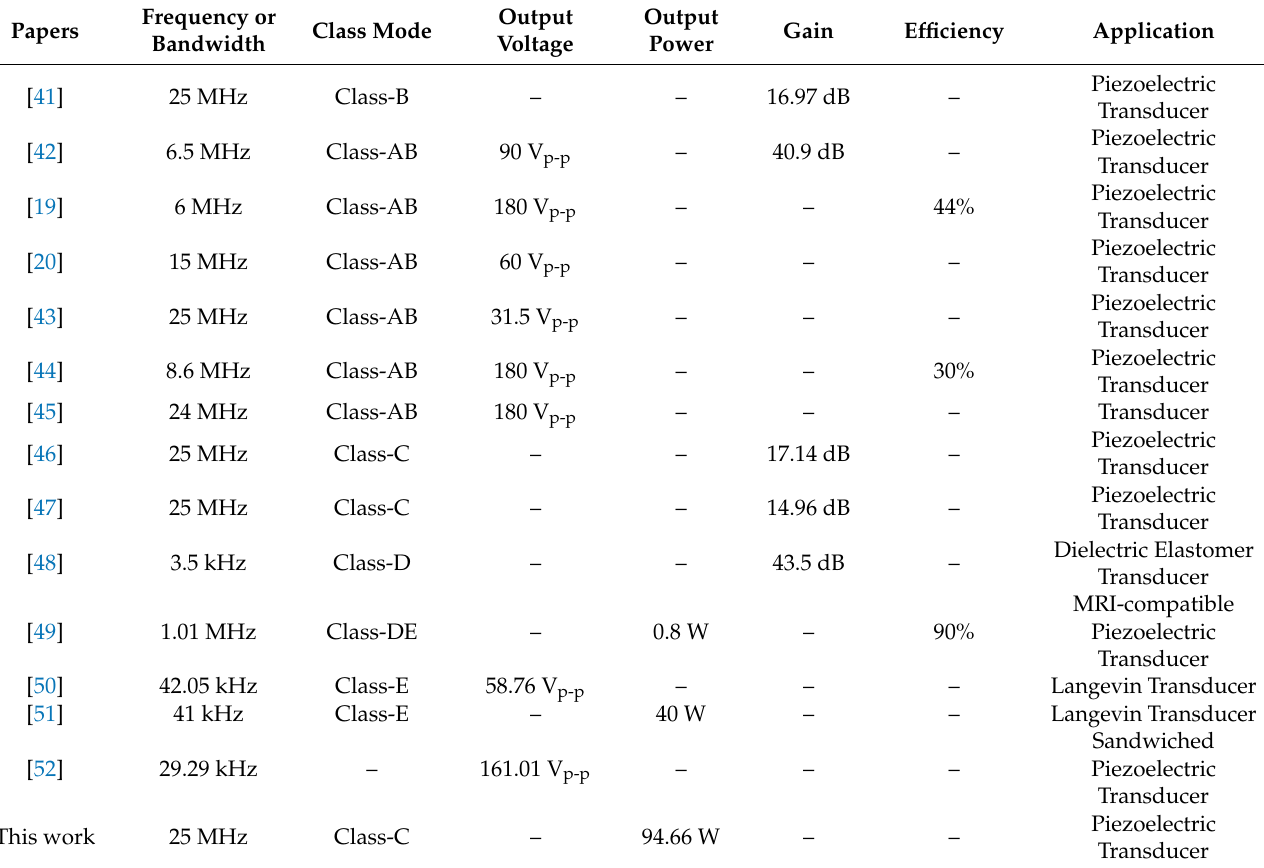
Table 1. Summarized performance of the comparison data of the power